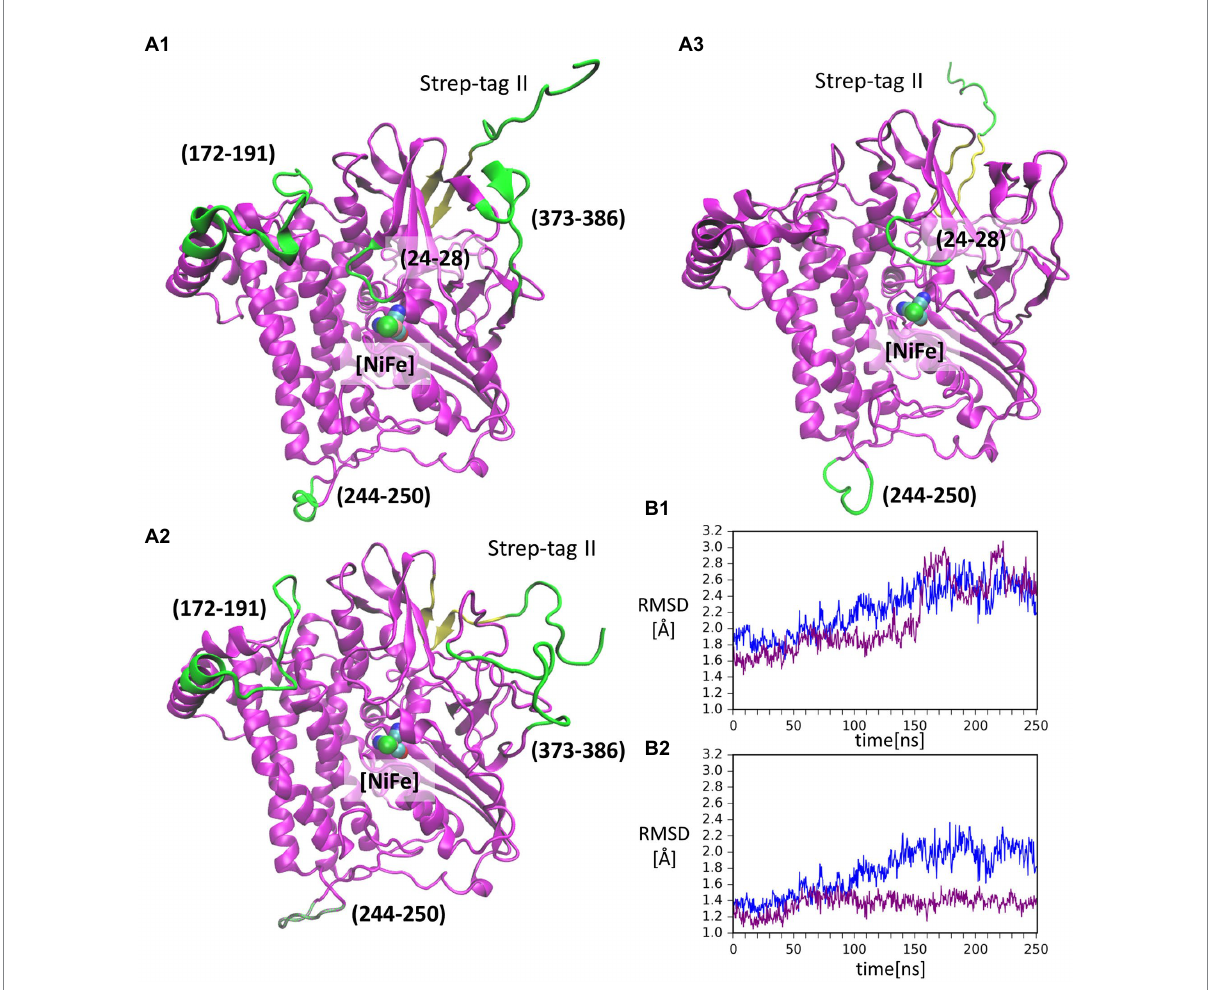
FIGURE 3 Conformations of the isolated large subunit, HoxG m from GaMD simulations: (A1) – initial modelled structure with N-terminal Strep-tag II. Flexible loops and structure elements that were excluded from RMSD calculation in (B2) are shown in green; (A2) – representation of mobility of Strep-tag II and loops with residues 171–191, 373–386, and 244–250, shown in time frame taken from simulation 2 after 199 ns; (A3) – representation of mobility of Strep-tag II and loops with residues 24–28 and 244–250, shown in time frame taken from simulation 1 after 156 ns. The β -sheet adjacent to the Strep-tag II is shown in yellow in all structures. [NiFe] active site is in vdW representation in all structures. Root-mean-square deviation (RMSD) of backbone atoms relative to the crystal structure [PDB code: 3RGW (Fritsch et al., 2011)] in GaMD simulations (blue – simulation 1, purple – simulation 2): (B1) – Strep-tag II was excluded from the calculation; (B2) – Strep-tag II and all flexible loops shown in (A1) were excluded from the